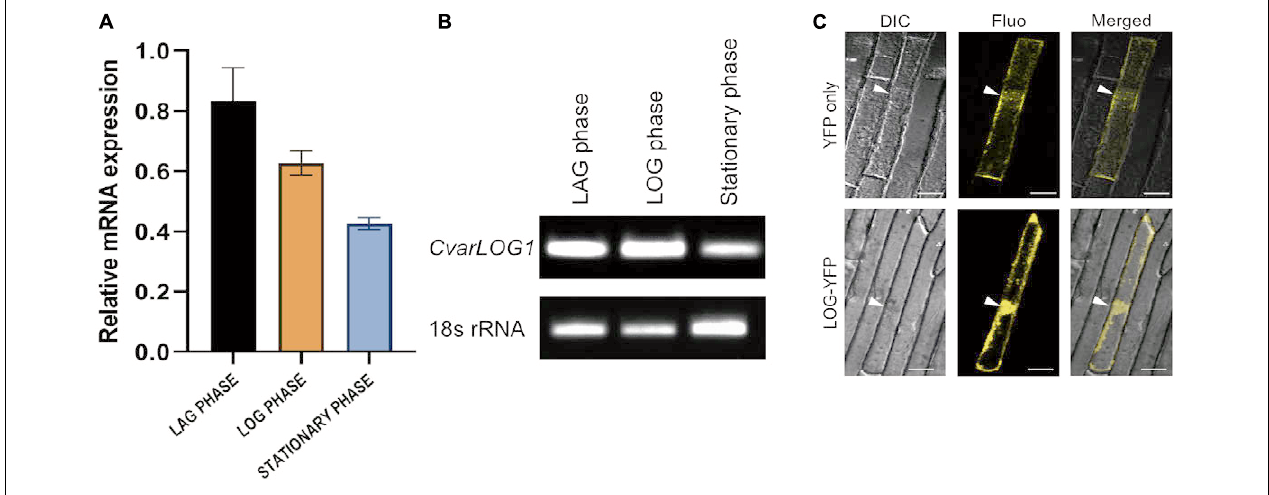
FIGURE 3 | Expression analysis of CvarLOG1 and in vivo localization CvarLOG1 protein. The levels of CvarLOG1 mRNA were checked across the growth phases of the alga. The growth phases can be divided into lag, log, and stationary phases. The levels of CvarLOG1 were quantified using total RNA extracted from each of these phases by (A) Quantitative PCR; bar indicates ± SE ( n = 3). (B) Semi-quantitative PCR, for both qPCR and semi-qPCR, 18s rRNA was used as the internal standard. (C) Sub-cellular localization of CvarLOG1-YFP fusion protein and YFP protein was done in onion epidermal cells transiently by particle bombardment and visualized using confocal microscopy. White arrows showing the nucleus. DIC, differential interference contrast; Fluo, fluorescence; Merged, overlay of DIC and Fluo. Bar = 50 µ